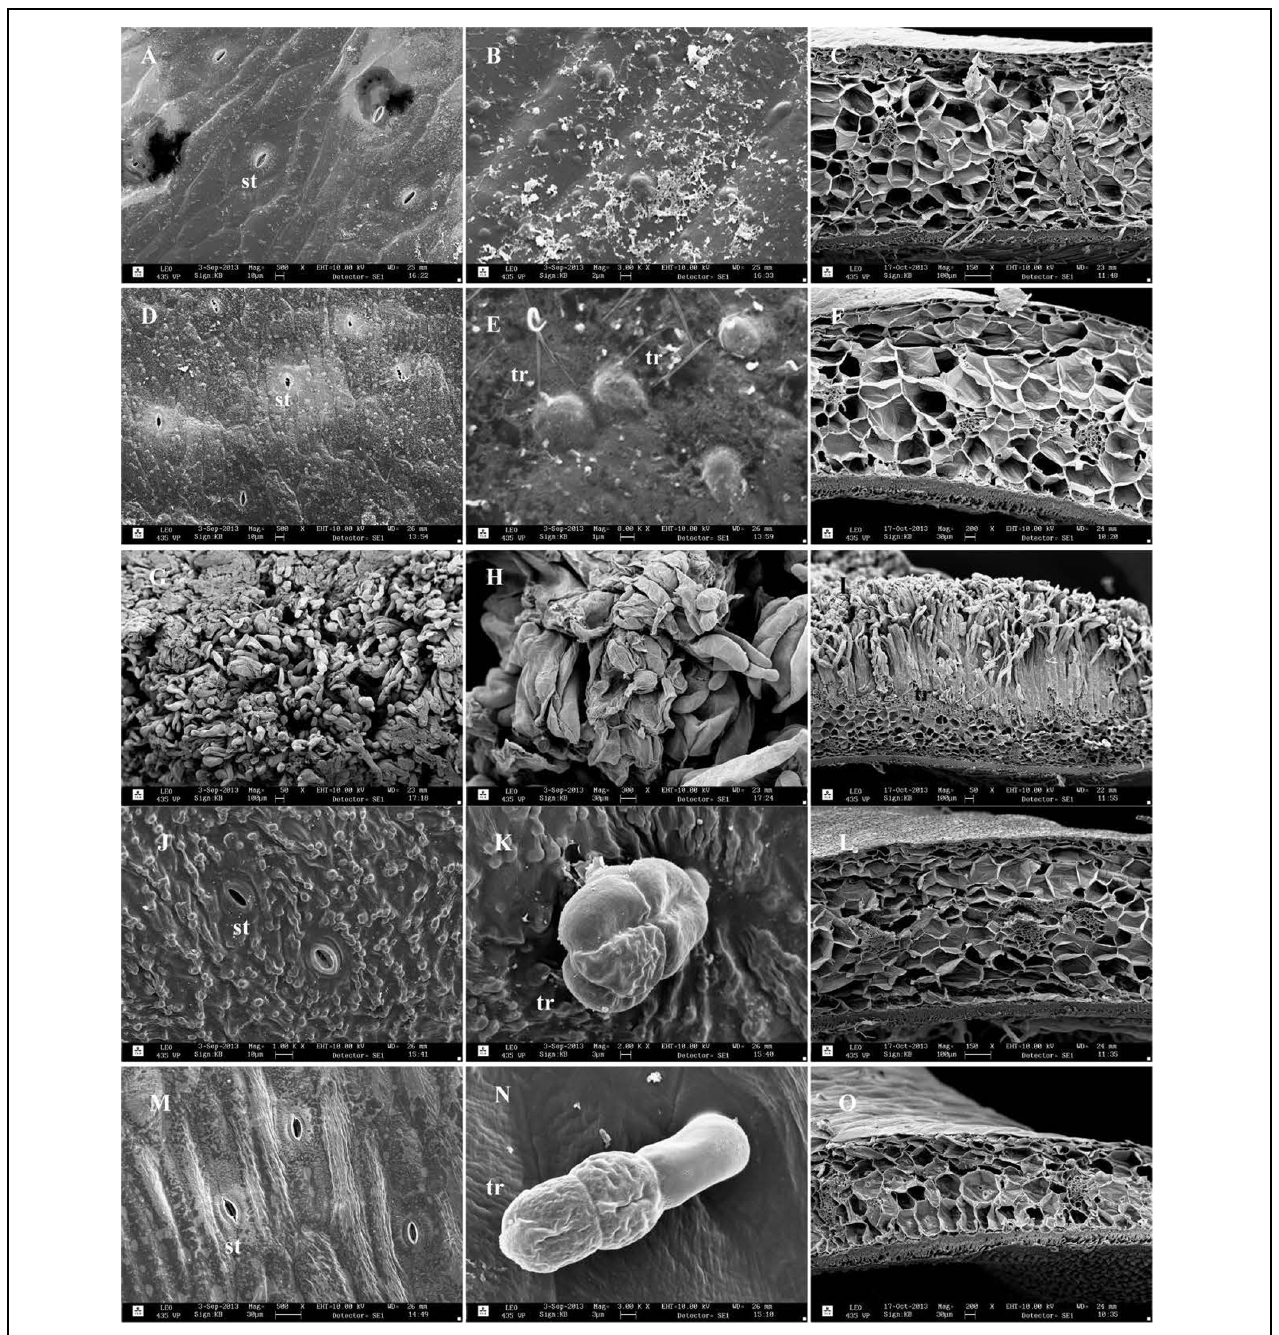
FIGURE 5 | Scanning electron micrographs of pod surface of field pea and non-host genotypes: (A–C; Adet ), (D–F; 32410-1 ), (G–I; 235899-1 ), (J–L; P . fulvum ), (M–O; L . sativus ). The first and the second columns show external pod surface; the third column is cross section of the pod wall. st, stoma; tr, trichome.